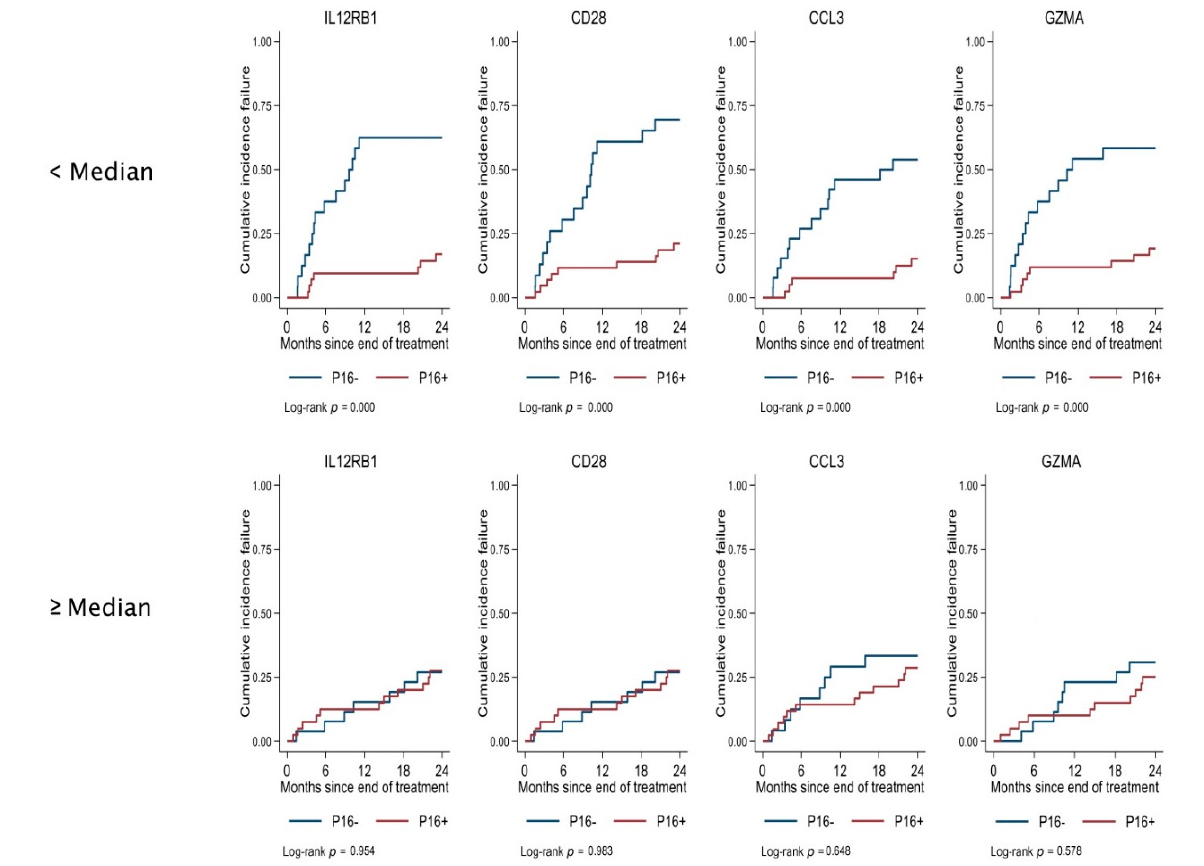
Figure 3. The interaction between p16 and proteins in relation to treatment failure. (< Median = Low values, ≥ High values. Y-axis: Cumulative incidence of failure. X-axis: Months since end of treatment). Table 2. Characteristics of patients without failure (recurrent tumour or death) within two years of the primary